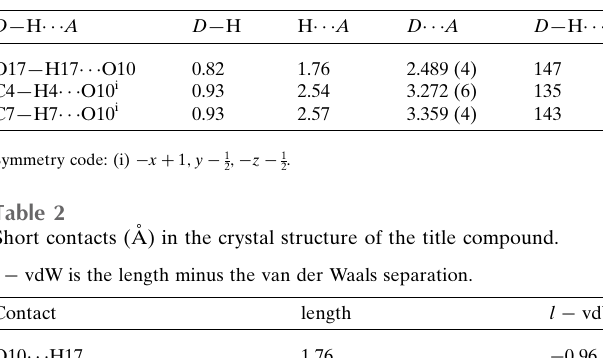
Table 1 Hydrogen-bond geometry (A˚ , (cid:2) ).